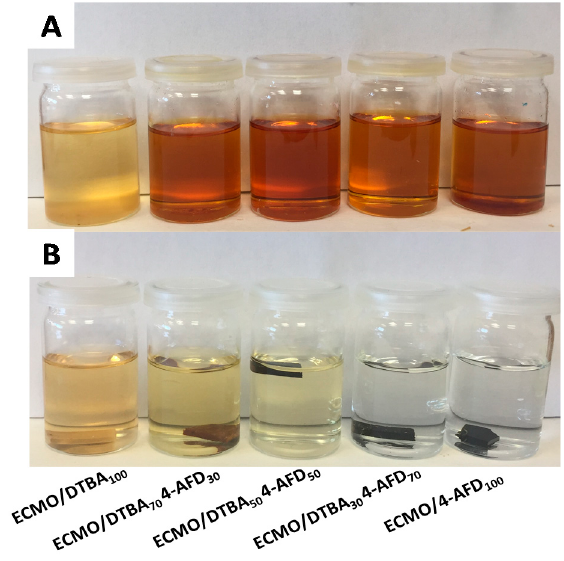
Figure 8. ( A ) Chemical recycling in DMF solution of dithiothreitol for ECMO/DTBA X 4-AFD X after 24 h at 50 °C and ( B ) solvent resistance in 1N NaOH solution after 3 days at room temperature.